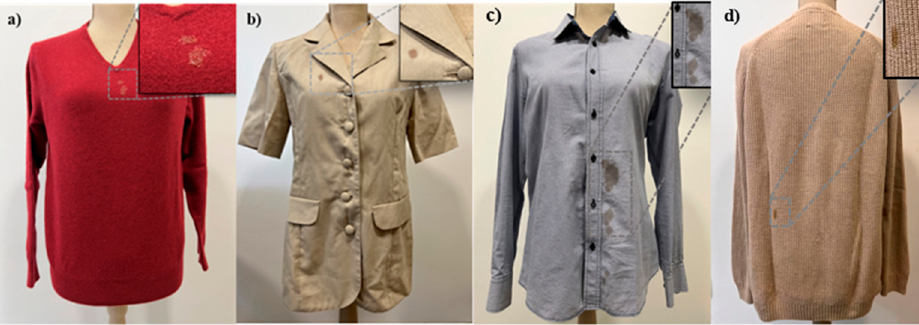
Figure 5. Sample images from stains dataset: ( a ) coffee stain; ( b ) wine stain; ( c ) multiple stains; ( d ) stain on the back.